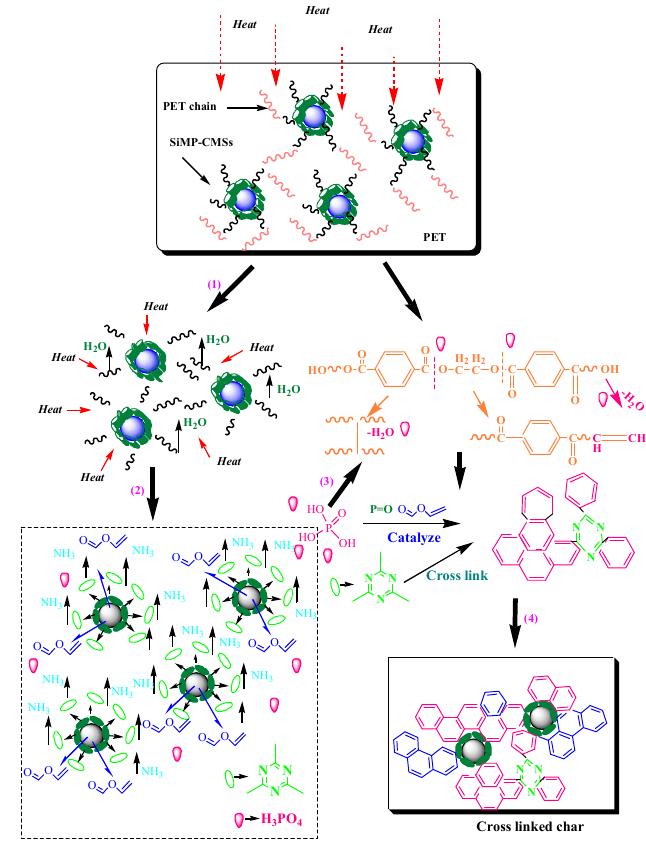
Figure 11. Process schematic diagram of the SiMP-CMSs flame retardant PET.